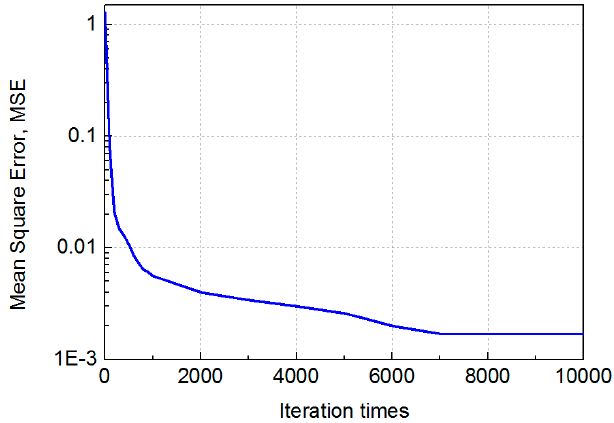
Figure 10. MSE performance with the even training data set. Table 3. Time cost of different algorithms with even training data set.